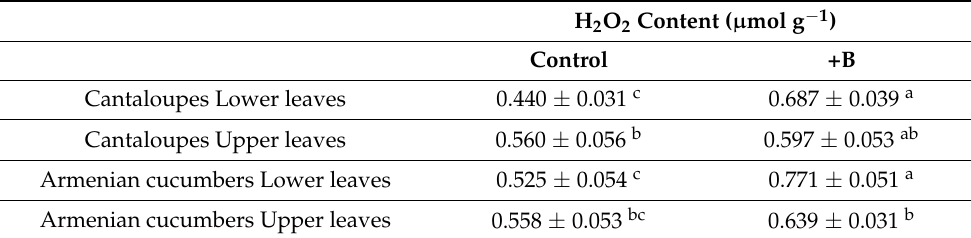
Table 2. Effect of the oversupply of B (by using H 3 BO 3 ) on the H 2 O 2 level of young (close to the apical meristem) and mature (close to the root-to-shoot intersection) leaves of cantaloupes ( C. melo var. Cantalupensis cv. Retato Degli Ortolani) and Armenian cucumbers ( C. Melo var. flexuosus cv. Abruzzese Tortarello). Growth period lasted 35 d, where no visible B toxicity symptoms were apparent (Figure 1). Means followed by different letters indicate significant differences ( p = 0.05). Values are the mean of ten replications ( ± SD). Content was expressed per fresh weight basis.